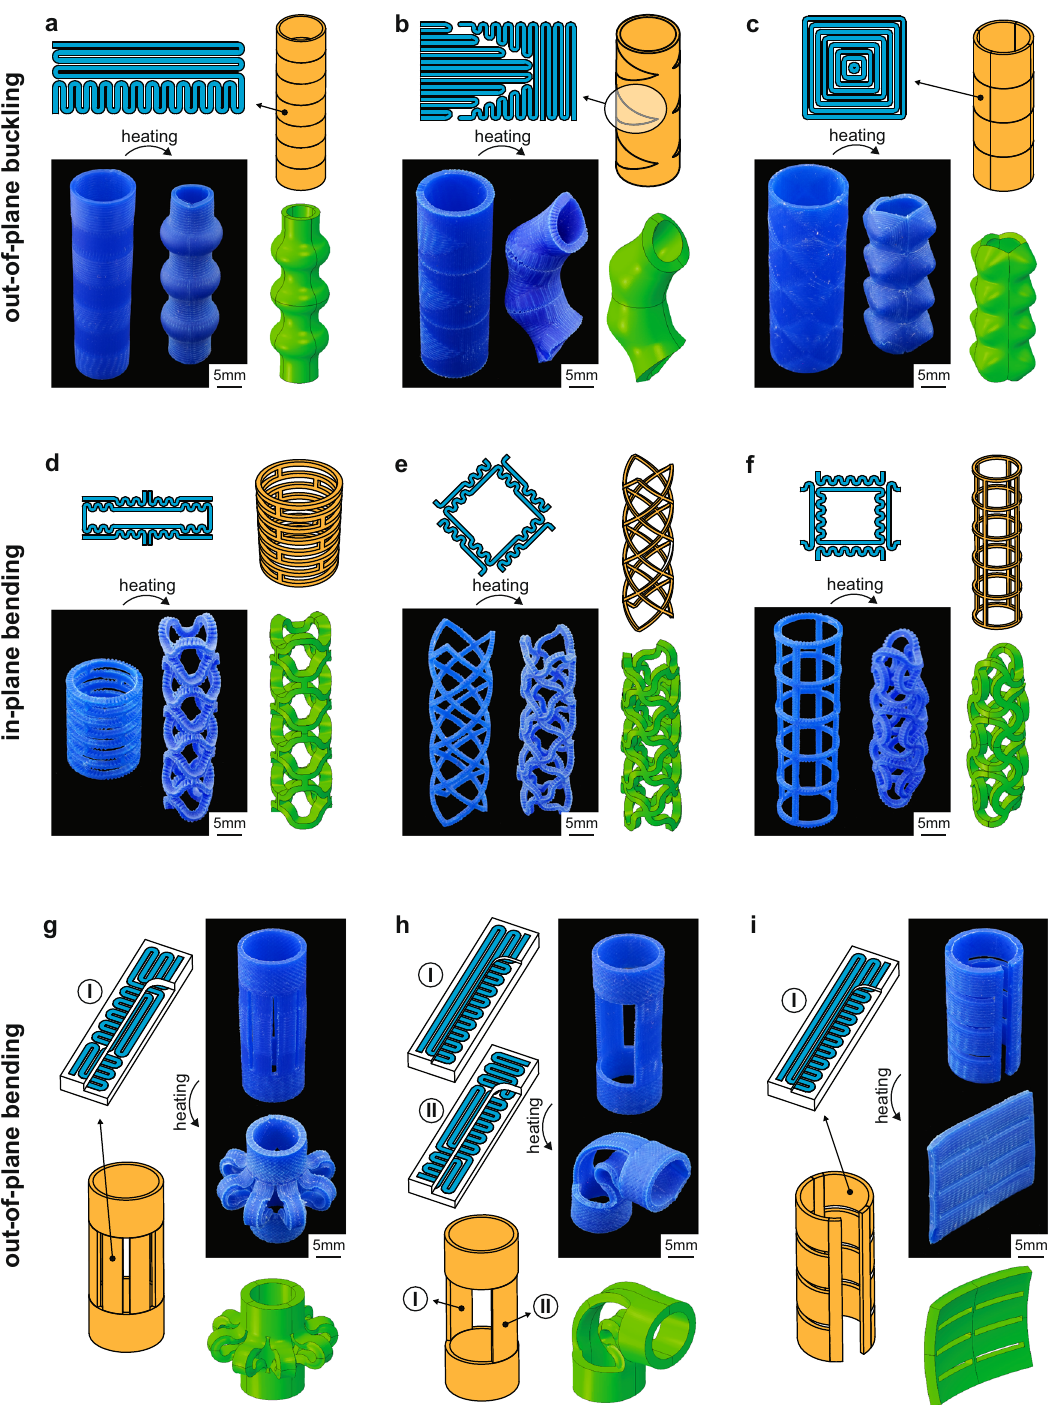
Fig. 2 Shape-shifting of a variety of curved samples. a – c Three examples of out-of-plane buckling specimens employing in-plane deformation patterns. d – f The shape-shifting behavior of cylindrical lattices with in-plane bending elements. g – i The shape-shifting specimens made of different arrangements of out-of-plane bending elements. In all cases, experimental and computational results are presented side by side. See Supplementary Videos 2 –